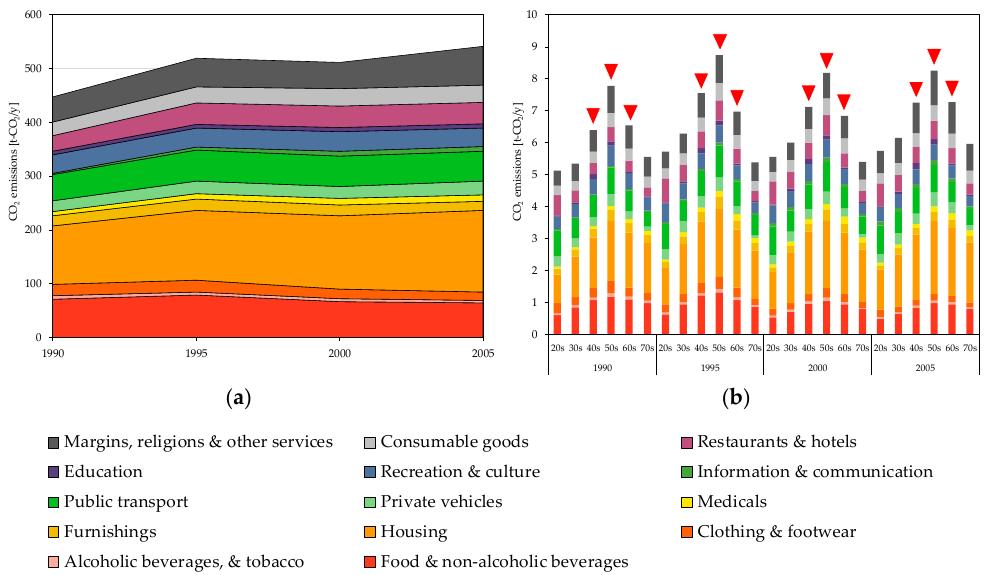
Figure 2. Sectoral composition of indirect CO 2 emissions from 1990–2005. (a) Total (Mt-CO 2 /y) and (b) per capita by age group (t-CO 2 /y). Inverted triangles denote the noteworthy household age groups as detailed in the main text.